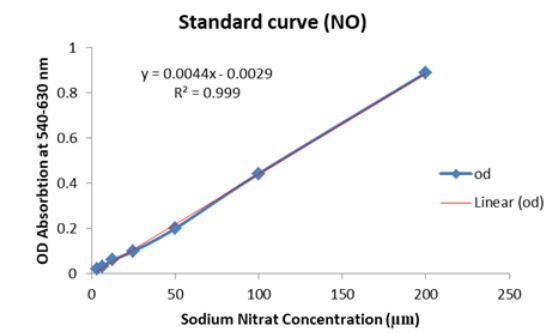
Figure 6. The standard curve for determining the nitric oxide (NO) assay.